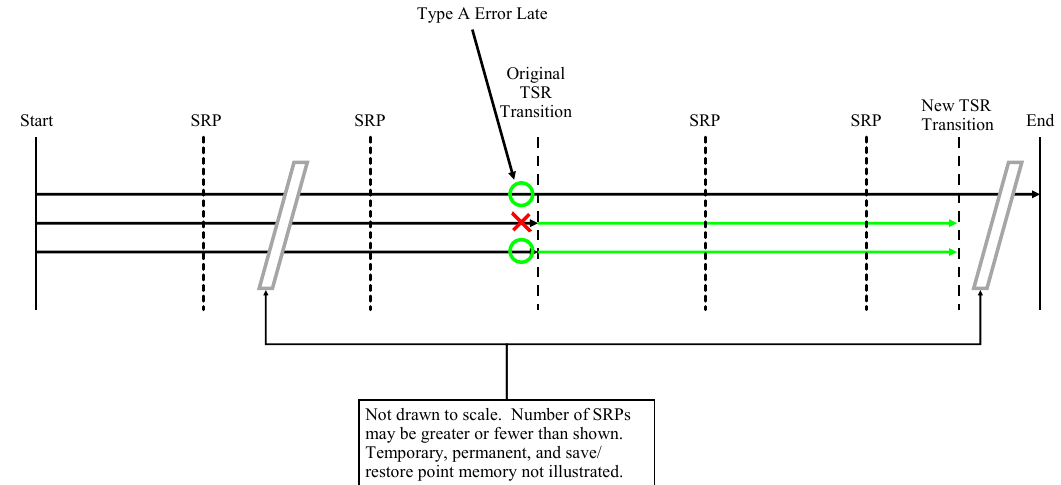
Figure A8. AHR MIPS TMR Type A Late error timing